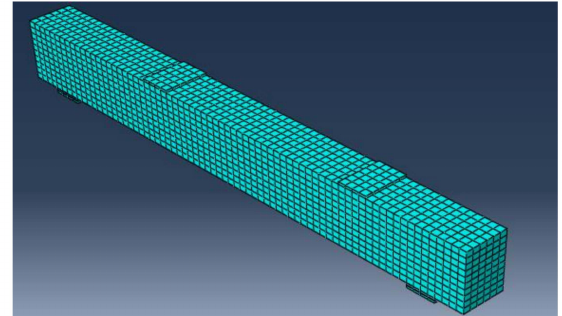
Figure 9. Concrete volume meshes for tested beams.